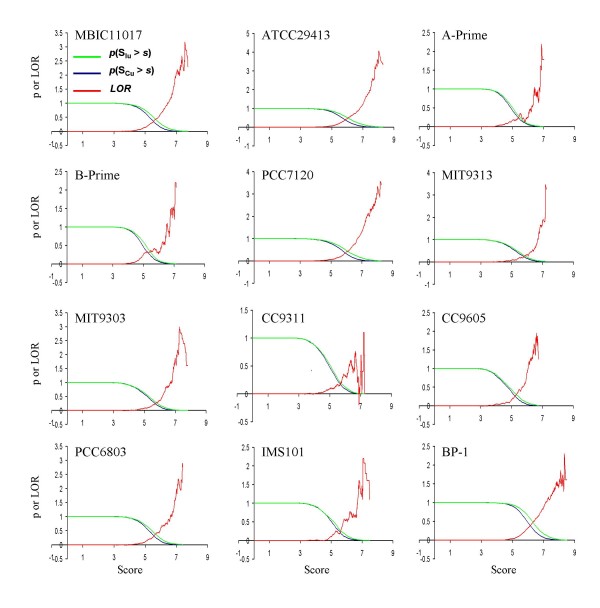
Evaluation of the genome-wide prediction of CRP regulons in 12 cyanobacterial genomes. The green curves represent the probability p(SIU>s) and the blue ones represent p(SCU>s). The red curves are the log-odd ratio (LOR), defined as LOR(s)=ln⁡(p(SIU>s)/p(SCU>s)) (see Methods).